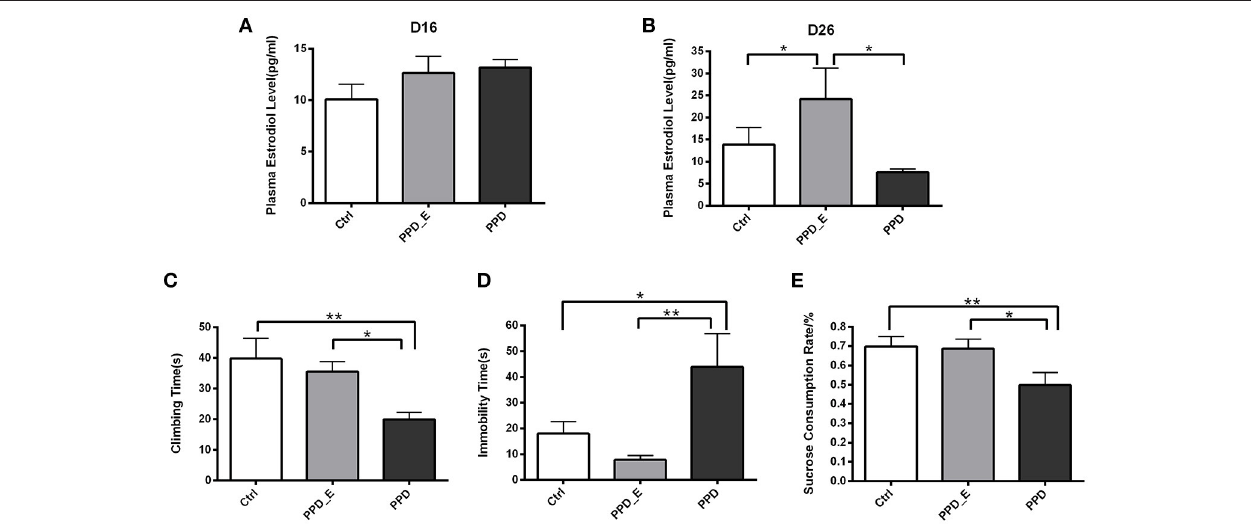
FIGURE 2 | Estradiol withdrawal-induced depressive-like behaviors in PPD rats . (A) After the 16-day 2.5 µ g E2 + 4mg progesterone treatment schedule, all groups had no significant difference in plasma estradiol levels. (B) After the 7-day 50 µ g E2 treatment schedule, PPD_E group showed a significant increase of plasma estradiol levels. (C) PPD group showed reduced climbing time than Ctrl and PPD_E group in forced swimming test. (D) PPD group showed increased immobility time than Ctrl and PPD_E group in forced swimming test. (E) PPD group showed a significant decrease of sucrose consumption than Ctrl and PPD_E group in sucrose